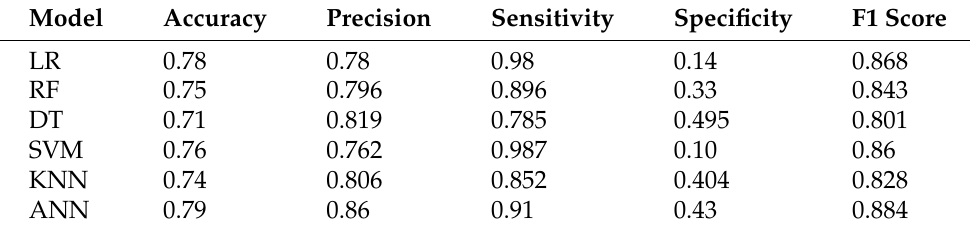
Table 7. Performance evaluation metrics for models used in this